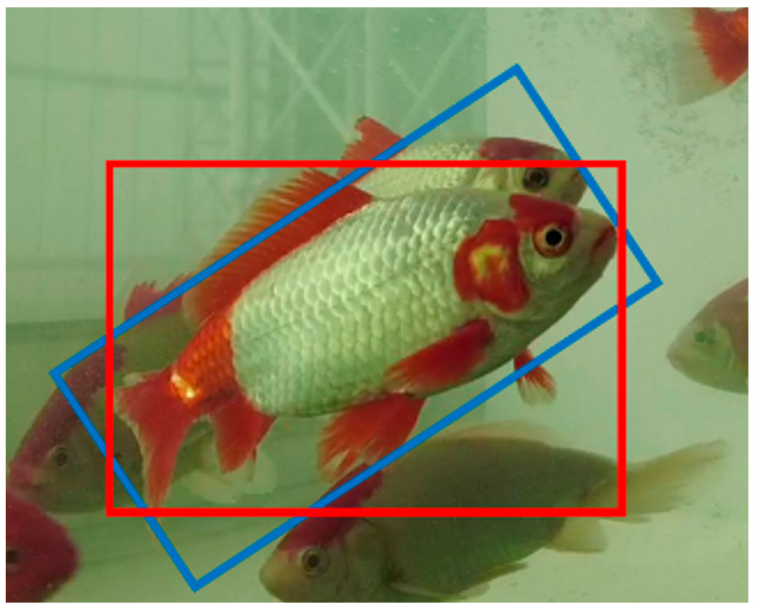
Figure 6. Target detection rotation frame and horizontal frame definition comparison chart. The red frame line represents the traditional horizontal frame, and the blue frame line represents the rotating frame.